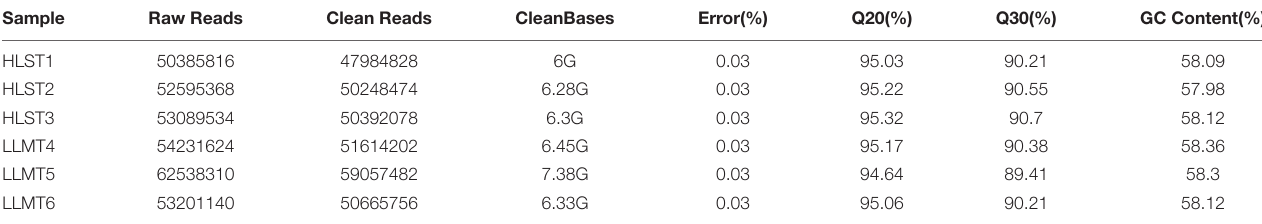
TABLE 1 | List of data output quality.